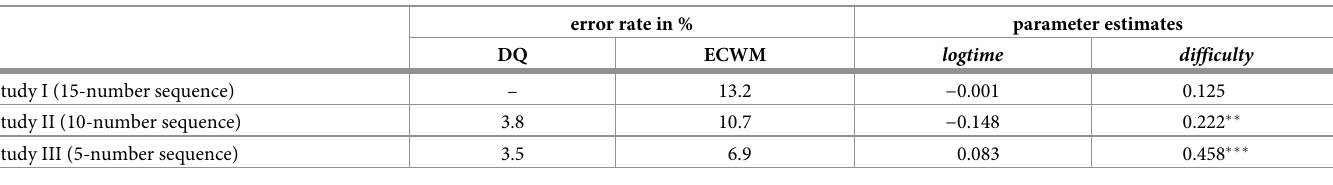
Table 4. Analysis of control